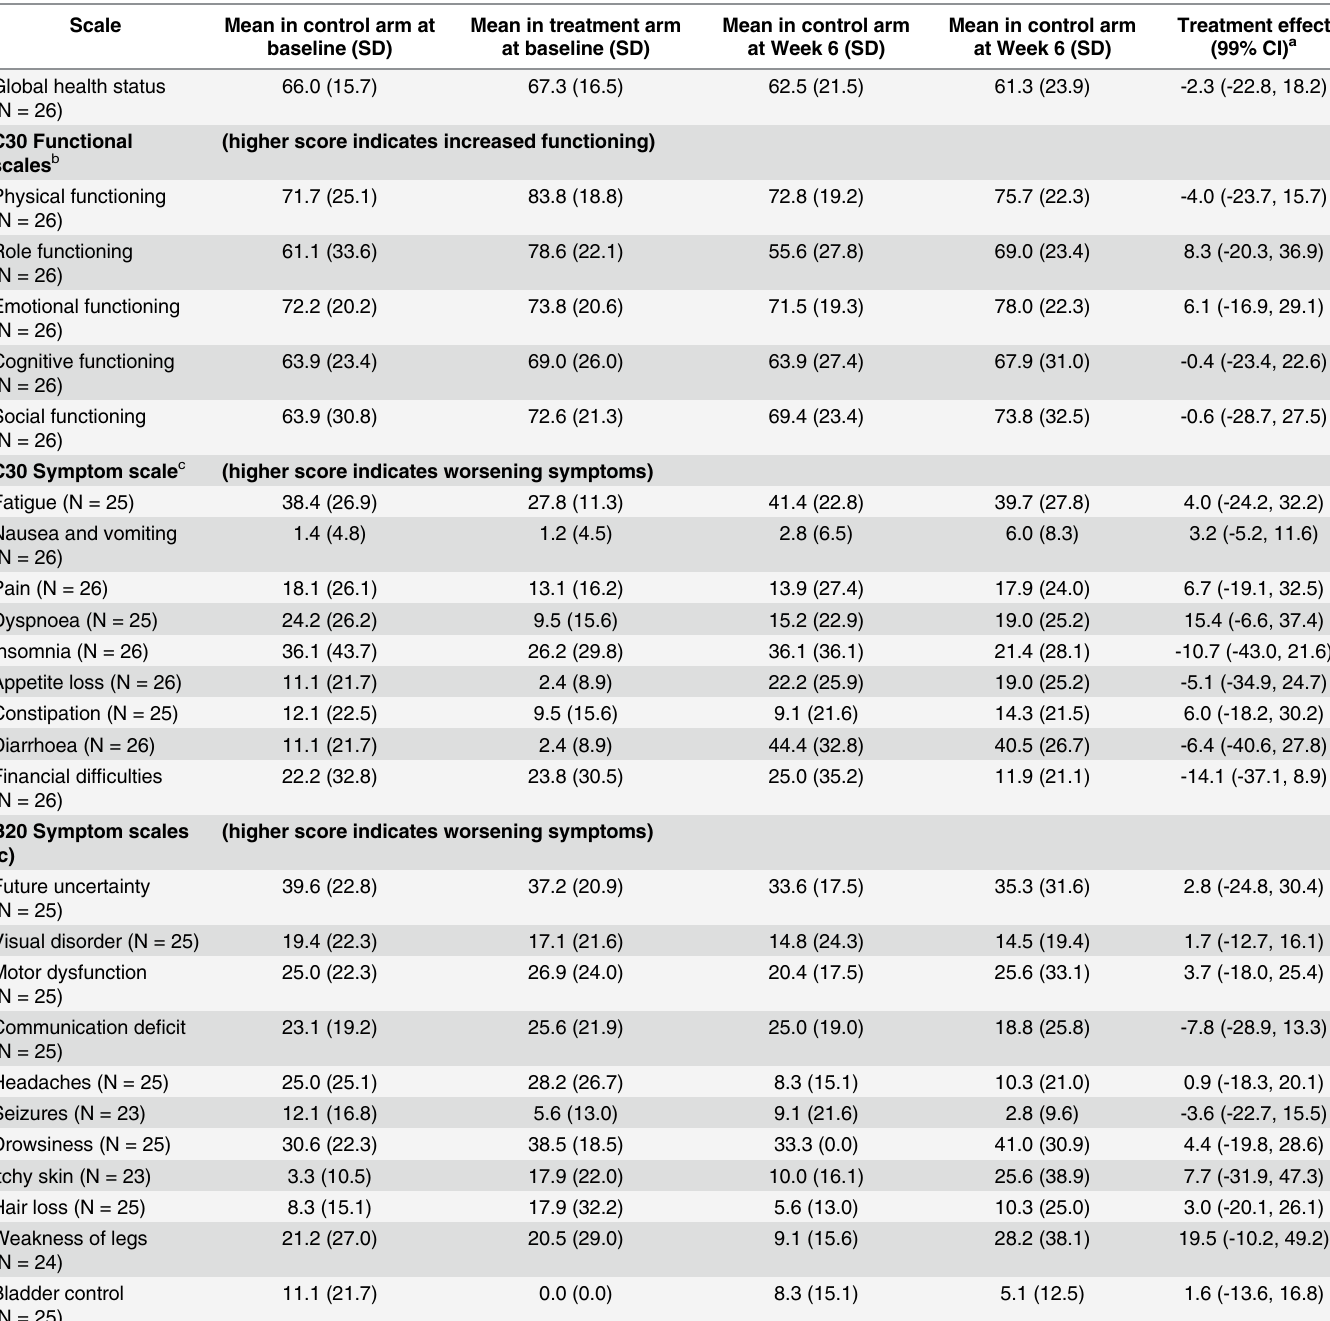
Table 3. Comparison of quality of life changes between baseline and week